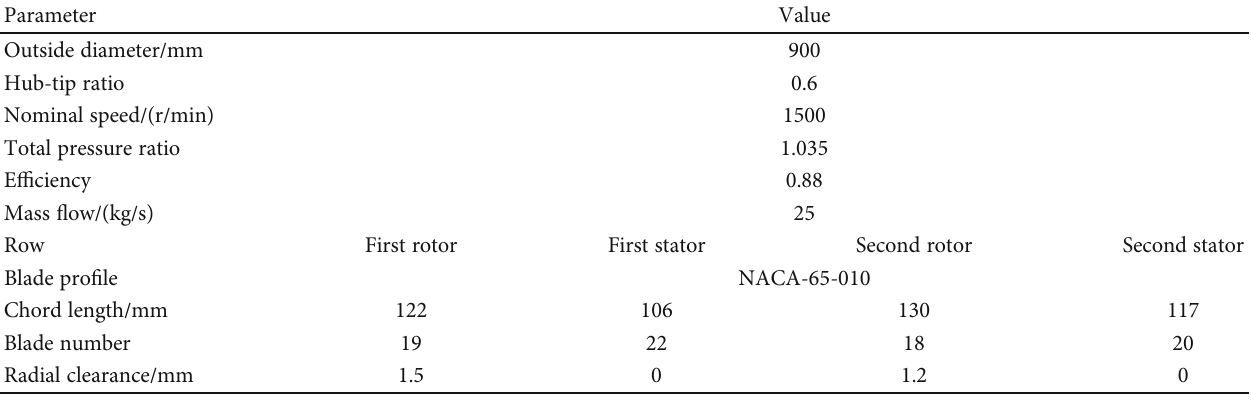
Table 1: Design parameters of the two-stage low-speed axial compressor.